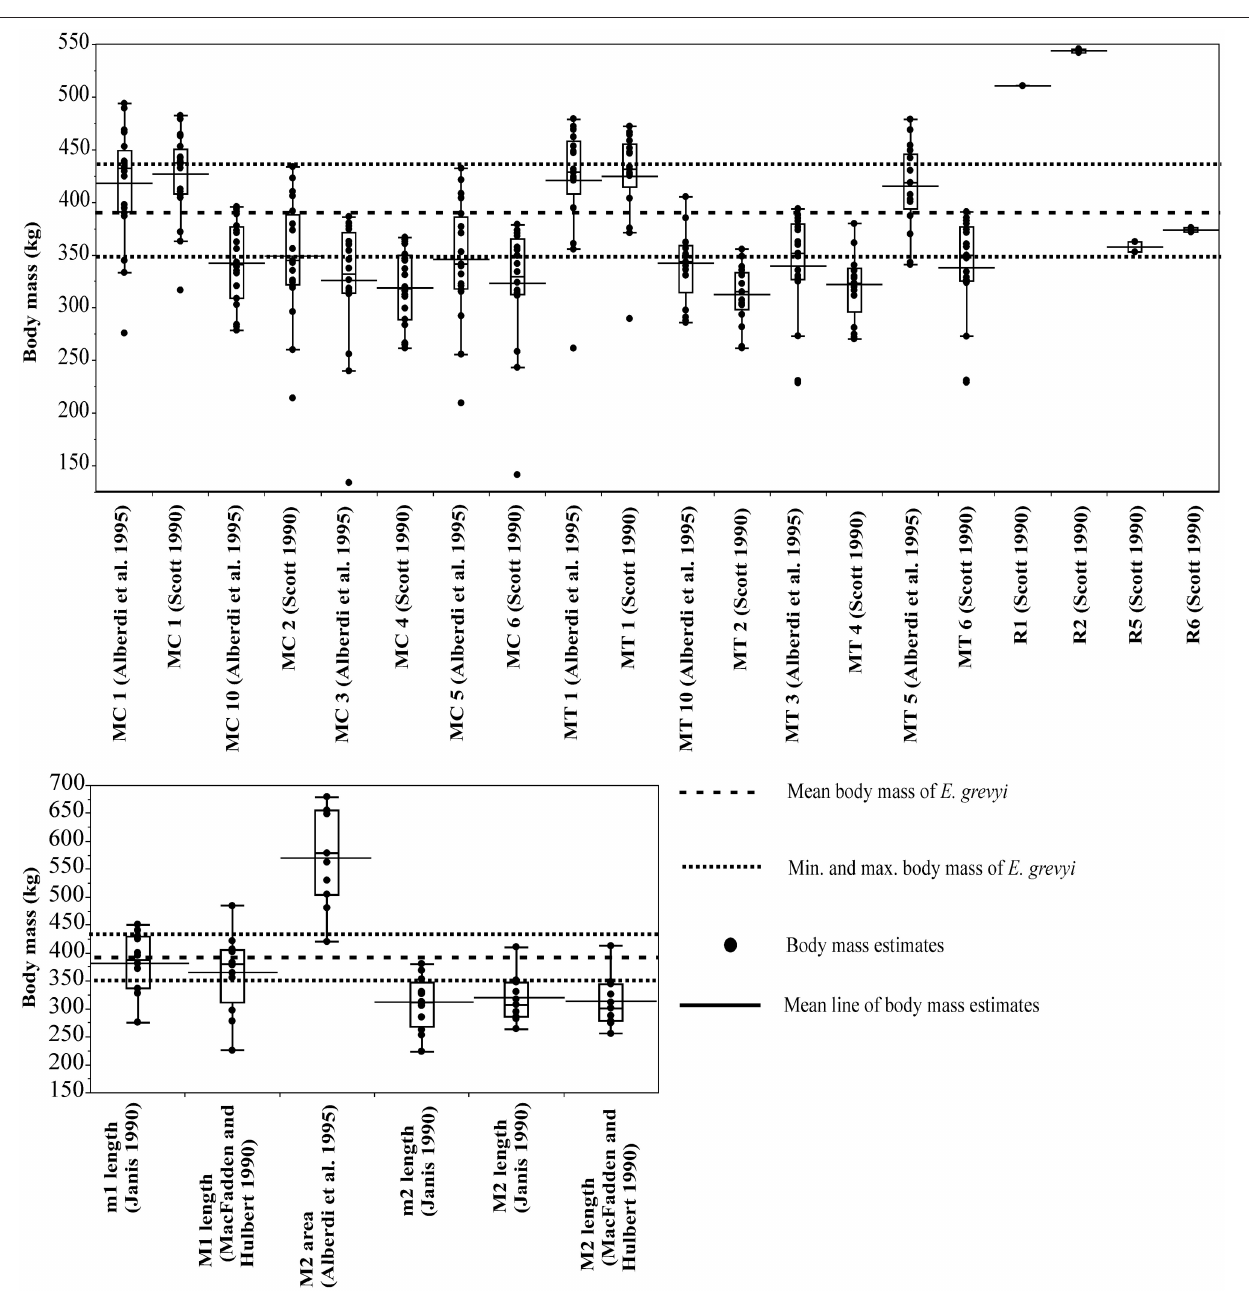
FIGURE 3 | Visual comparisons of body mass estimates from various skeletal and dental measurements with reported mean, minimum and maximum body mass of Grevy’s zebra ( Equus greyi ). Box plots and mean lines are provided for the body mass estimates from each skeletal and dental measurement, and the reported minimum, maximum and mean body mass are from Kingdon and Hoffmann (2013). The central line in the box plot indicates the median, the box covers the interquartile range (IQR) and the upper and lower whiskers are 1.5*IQR. In addition, a mean line is shown as a horizontal line extending outside the vertical limits of the box. Bone and measurement codes are as in Table 1